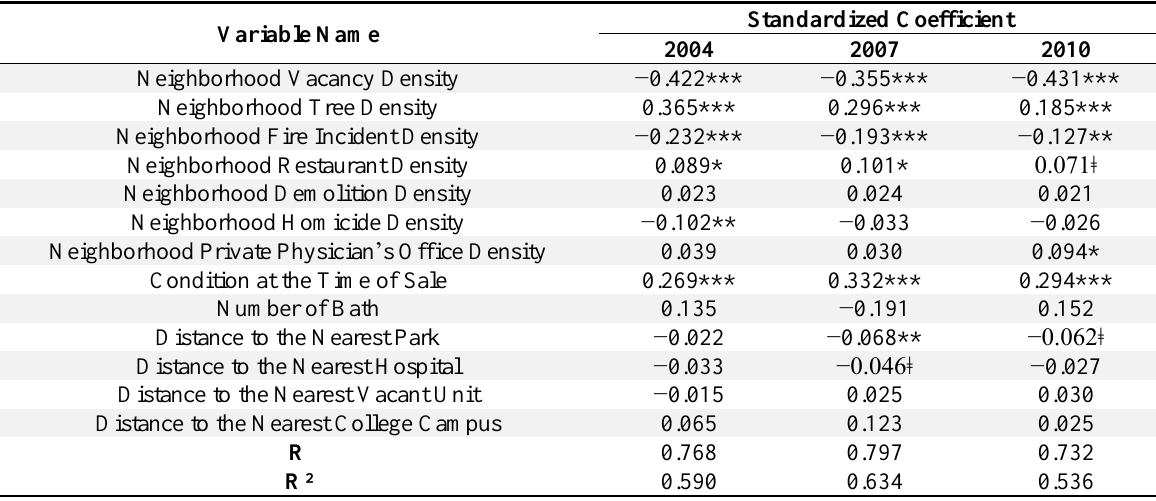
Table 3. Hedonic model on unit housing sale